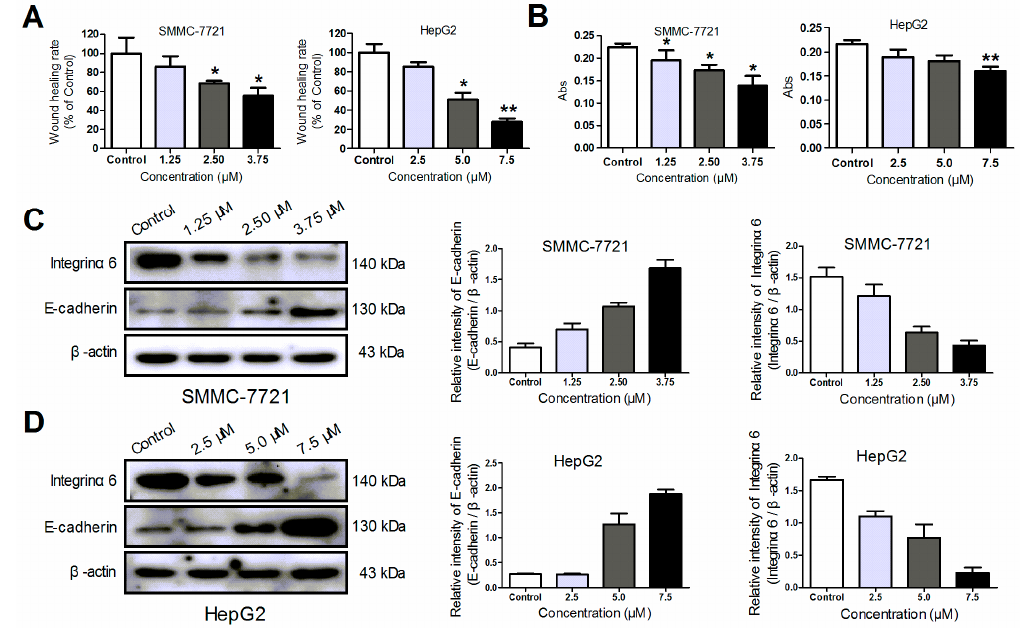
Figure 5. The compound 3a inhibited invasion and migration of SMMC-7721 and HepG2 cells. ( A ) 3a at different concentrations inhibited SMMC-7721 (1.25, 2.5, 3.75 µM) and HepG2 (2.5, 5.0, 7.5 µM) cells migration ( n = 3, x ± SD, * p < 0.05, ** p < 0.01); ( B ) Transwell inserts coated with matrigel were used to examine the invasion ability of SMMC-7721 and HepG2 cells treated with compound 3a . Representative images were shown and cell invasion ability was expressed by the optical density value ( n = 3, x ± SD, * p < 0.05, ** p < 0.01); ( C ) The expression levels of E-cadherin and integrin α 6 in SMMC-7721 cells were measured using western blotting; ( D ) The expression levels of E-cadherin and integrin α 6 in HepG2 cells were measured using western blotting. All of the experiments were repeated three times for each group and the other results were consistent.